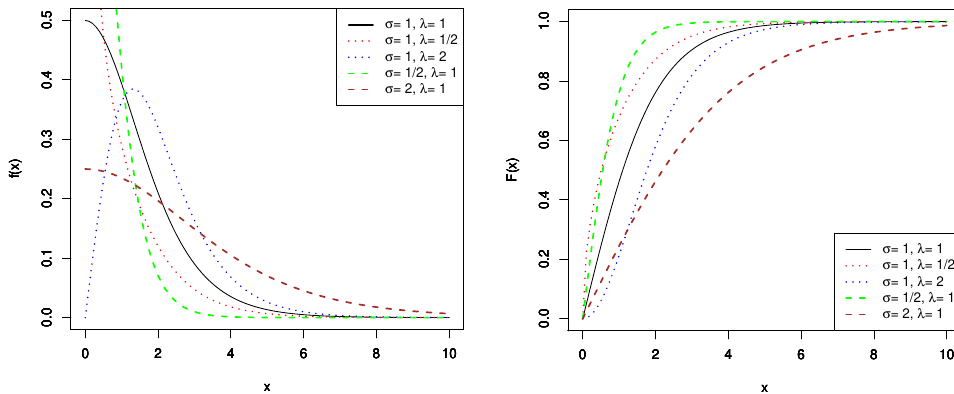
Figure 1. PDF ( left ) and CDF ( right ) of the exponentiated half-logistic distribution. Based on L’Hospital’s rule, the failure rate function approaches 1 when x approaches σ infinity as Figure 2 shows. According to [10], gamma distribution and exponentiated half-logistic distribution have the same attributes as the PDF and behaviors of the failure rate function when shape parameters are larger than one. However, the CDF, reliability, and failure rate functions of the gamma distribution do not have a closed form when the shape parameter is not an integer. Thus, the exponentiated half-logistic distribution, whose overall distribution has a closed structure, performs better than the gamma